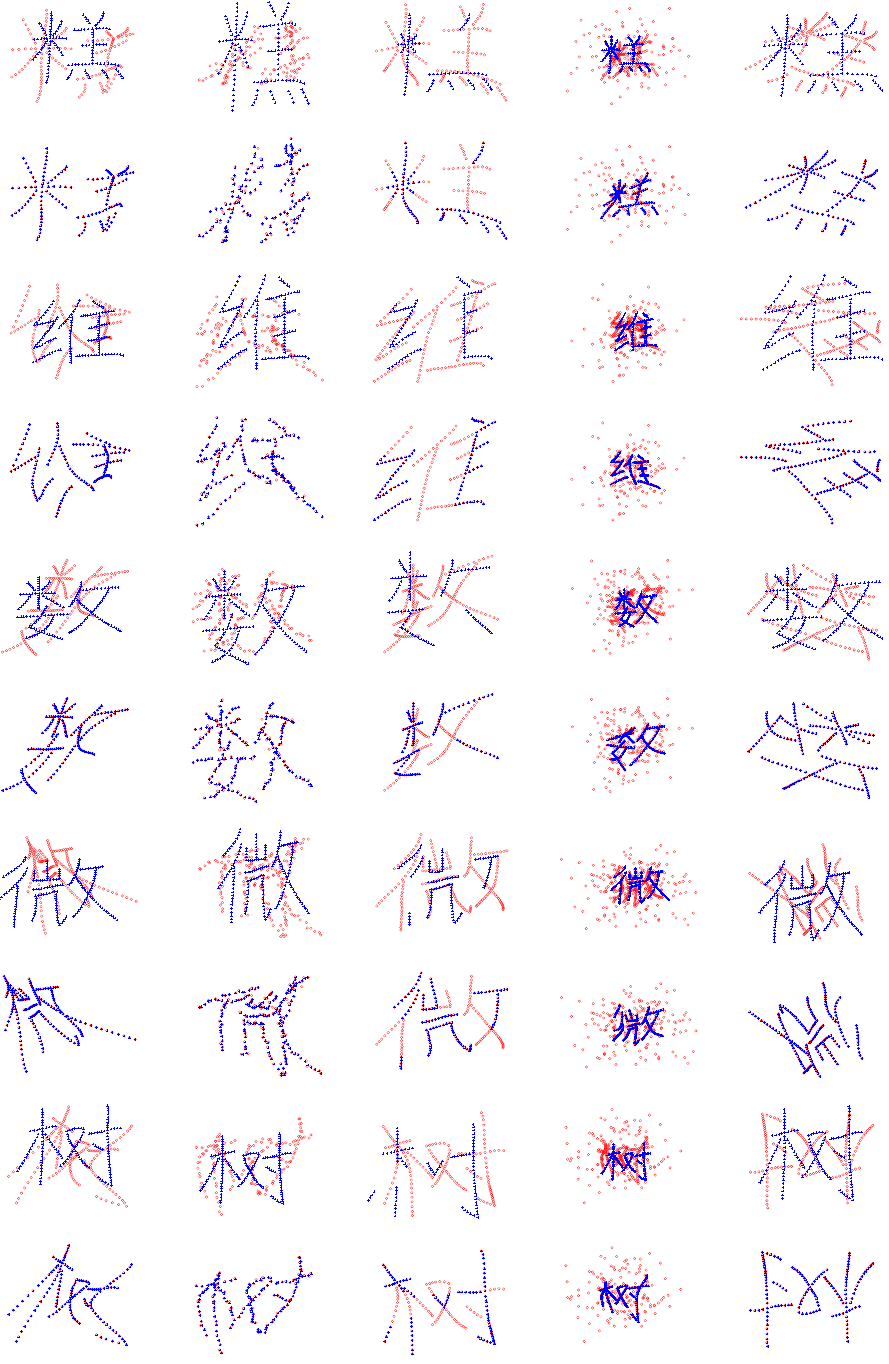
Figure 3. Registration results on Chinese character dataset. From top to bottom: “ cake, ” “ dim, ” “ math, ” “ micro, ” and “ tree ” in every two rows; the upper row shows the data and the lower row shows the registration results. From left to right: deformation, noise, occlusion, outliers, and rotation. The model points and the scene points are marked by “ + ” and “o,”